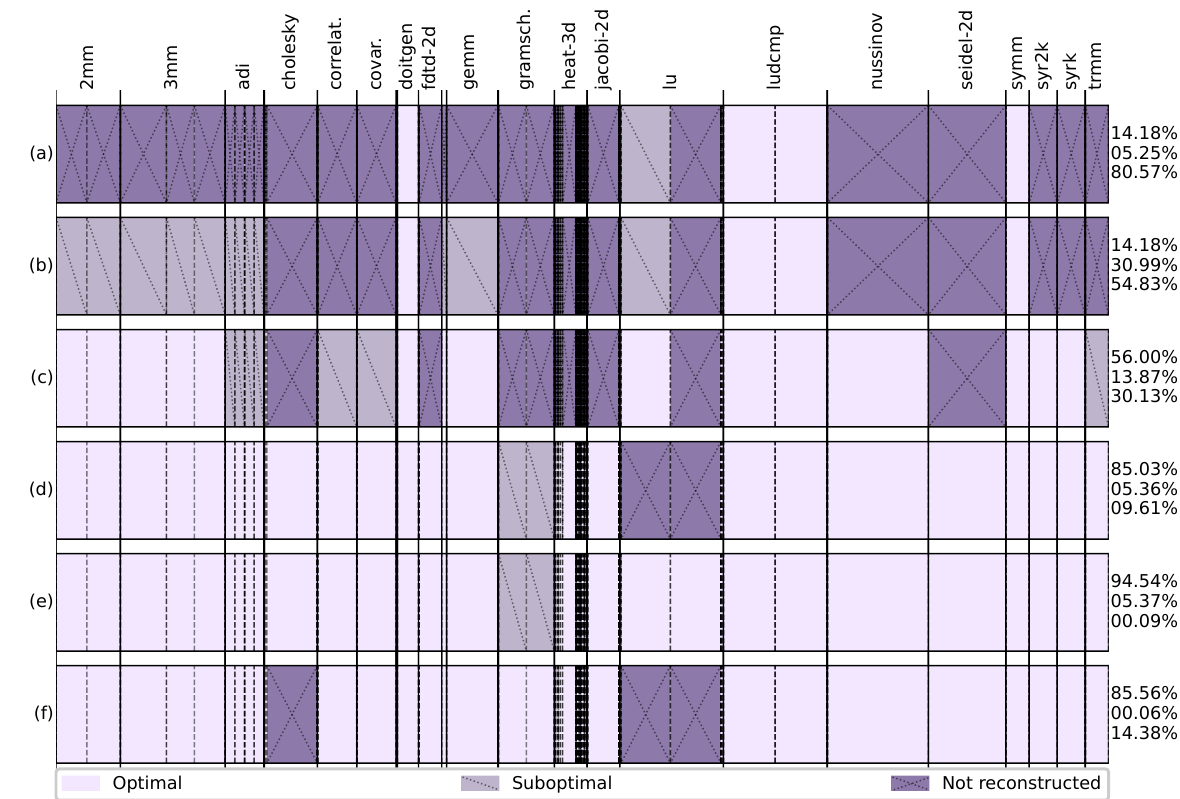
Figure 7. Reconstruction results of piecewise-affine traces using different approaches and exploration heuristics. Each row represents the results obtained by a different reconstruction strategy: ( a ) applying the single-domain TRE without modification (Section 4.1); ( b ) applying the single-domain TRE with heuristic traversal (Section 4.1); ( c ) generalized TRE including multiple upper bounds only (Section 4.2); ( d ) generalized TRE with multiple upper and lower bounds (Section 4.3); ( e ) same as ( d ) with improved heuristic exploration (Section 4.4); and ( f ) same as ( e ), but allowing rational coefficients (Section 4.5). Applications are separated by a continuous line and each box represents a loop scope. The three numbers to the right of each row represent, from top to bottom, the percentage of total accesses in scopes reconstructed optimally, sub-optimally, and not reconstructed. Some applications are not labeled due to space constraints, but the figure includes all PolyBench